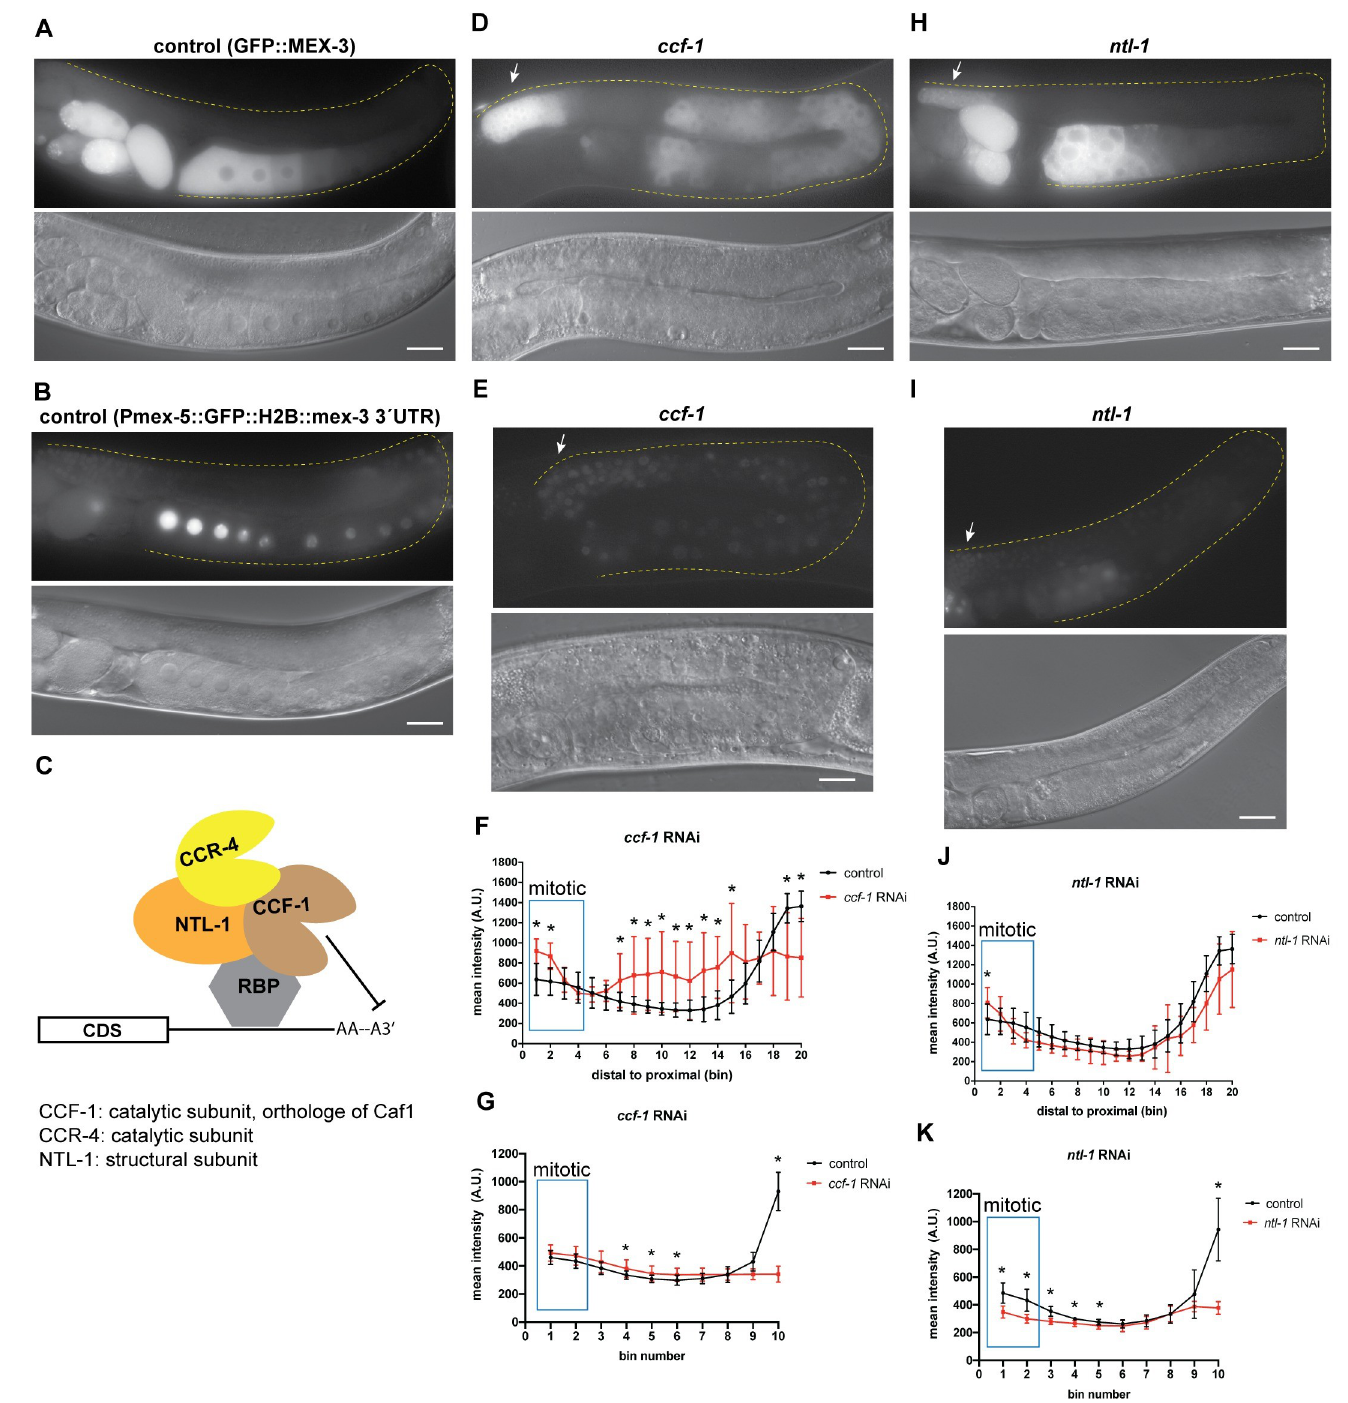
Fig 7. De-adenylation contributes to regulation of MEX-3 in the germline. (A) DIC and fluorescence images of wild type GFP::MEX-3 animals from the control RNAi. (B) DIC and fluorescence images of the gfp :: mex-3 3´UTR transgenic reporter strain from the control RNAi. (C) a model representing the known mechanism of CCF-1, NTL-1, and CCR-4 mediating poly(A) deadenylation. CCF-1 and CCR-4 are the deadenylases while NTL-1 is a structural subunit. CCF-1 is the major de- adenylase. All three proteins are thought to form a complex. (D) DIC and fluorescence images after ccf-1 knockdown in the GFP::MEX-3 strain. GFP::MEX-3 expression was significantly increased in the distal mitotic end. (E) DIC and fluorescence images after ccf-1 knockdown in the gfp :: mex-3 3´UTR transgenic reporter strain. (F) quantitative analysis of fluorescence intensity after ccf-1 knockdown in the GFP::MEX-3 strain (n = 15/15). (G) quantitative analysis of fluorescence intensity